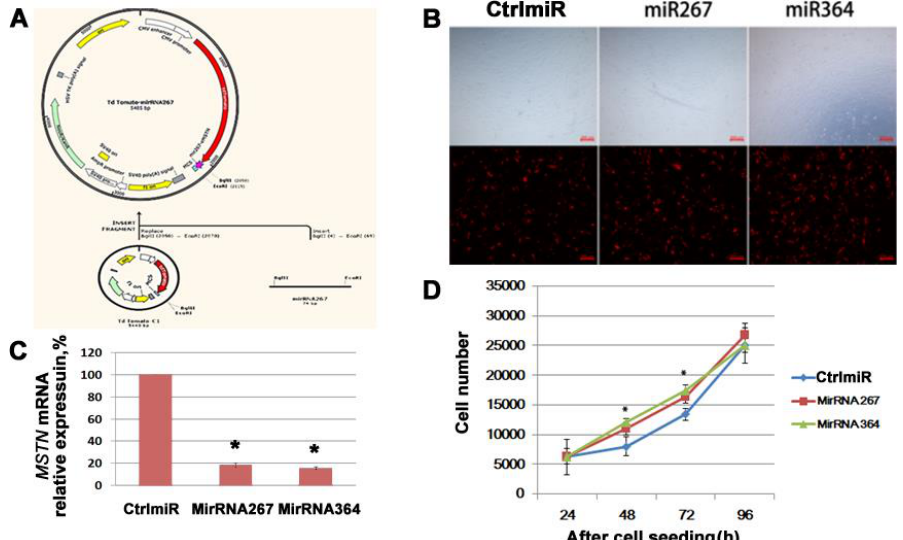
Figure 2. The effect of MSTN knockdown on HMSC proliferation. ( A ) Plasmid construction images in SnapGeneTM1.1.3 Software for equine MSTN knockdown plasmid. ( B ) After 24h transfection in Mongolian horse SCs in monolayer cultures. ( C ) qPCR validation of the interference efficiency. ( D ) Cell proliferation curves for different groups. * represents p < 0.05.